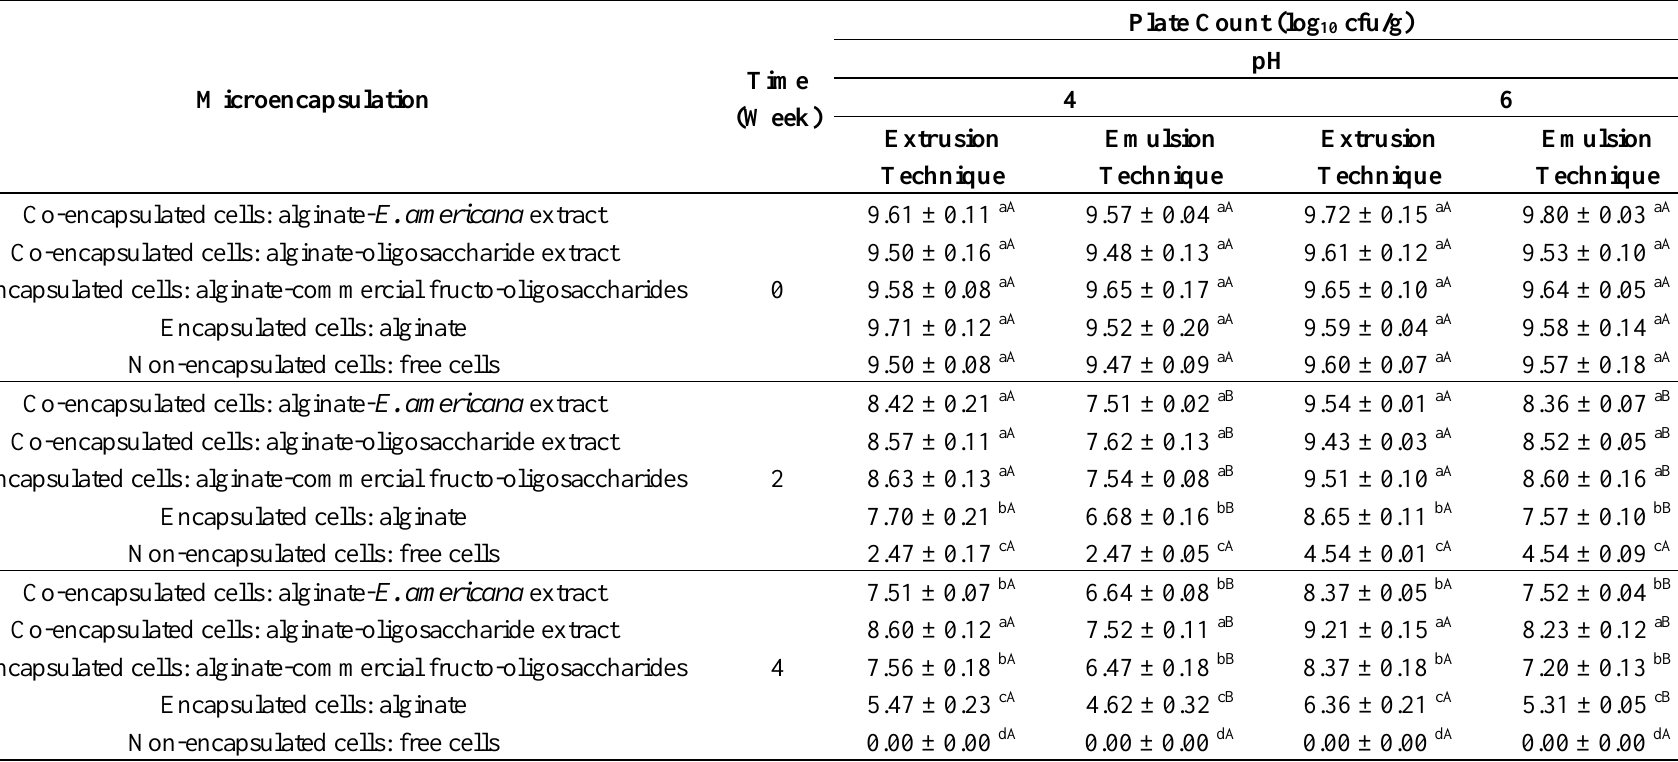
Table 4. Survival of microencapsulated Bifidobacterium longum with Eleutherine americana under refrigeration